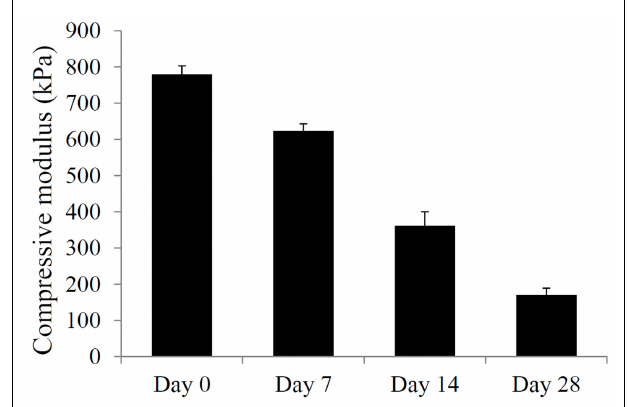
FIGURE 2 | Mechanical property of mPDLLA-PEG/HA scaffolds incubated in HBSS at 37°C for different times up to 28days . Difference between every two groups is statistically